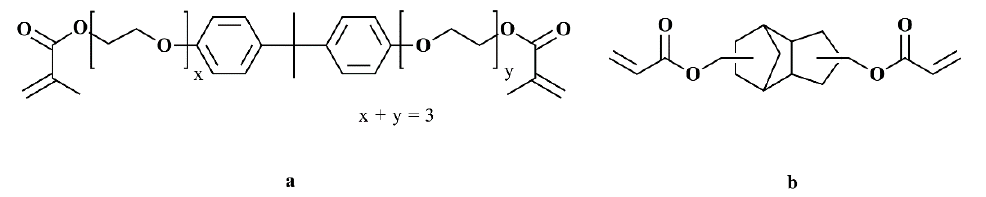
Figure 2. Chemical structures of ( a ) SR348C and ( b ) SR833S .